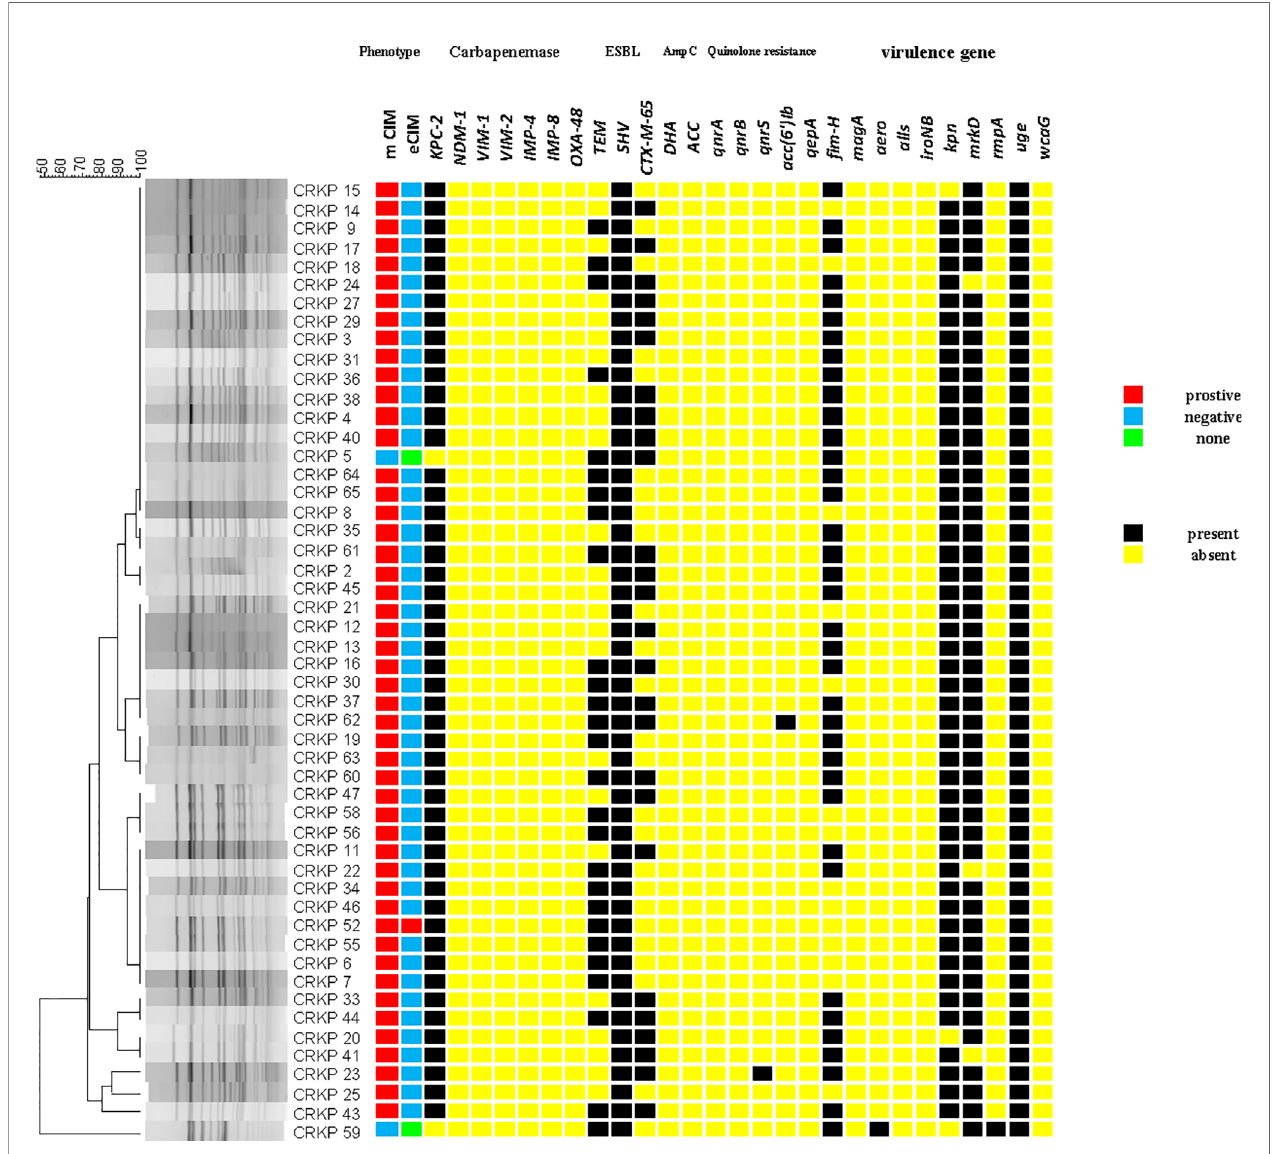
FIGURE 4 | The carrying status of phenotype, drug resistance genes, virulence genes and homology heat map of